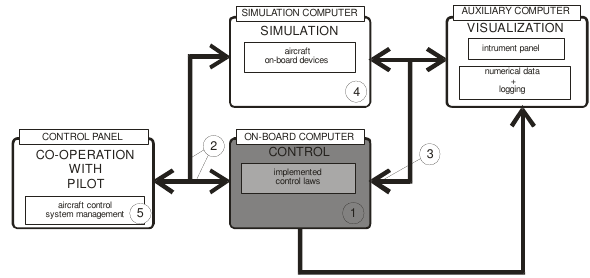
Fig 2. Diagram of stand configuration purposed for testing